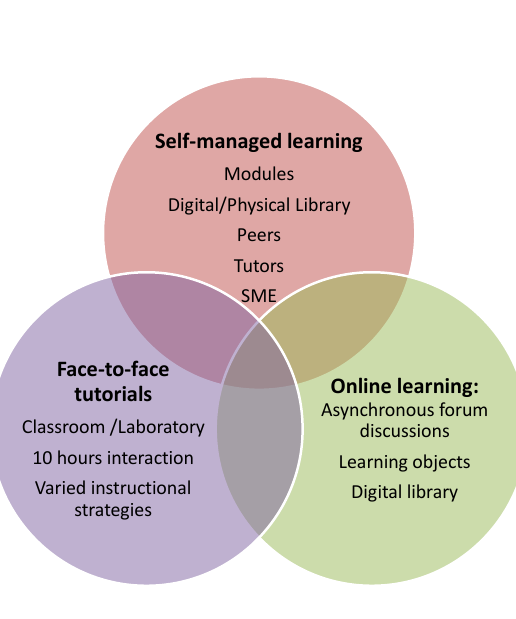
Figure 1. Blended learning approach at